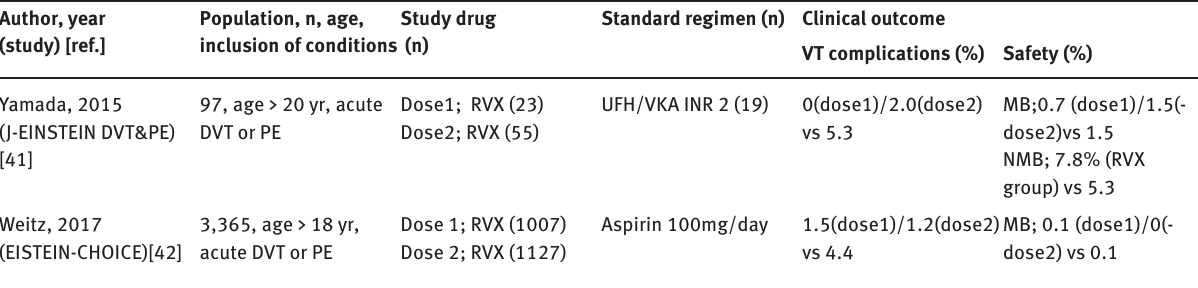
Table 2 continued: Clinical data on the use of direct oral anticoagulants in the treatment of venous